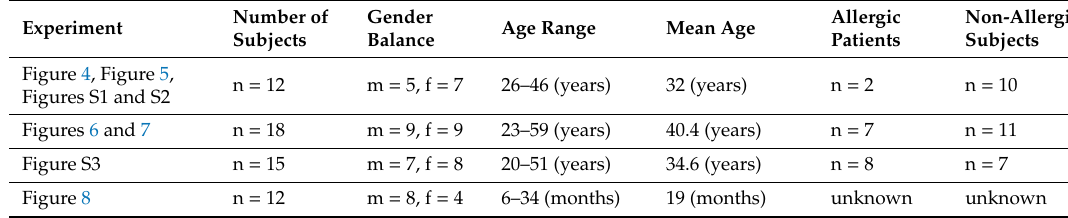
Table 2. Demographic characterization of study subjects.